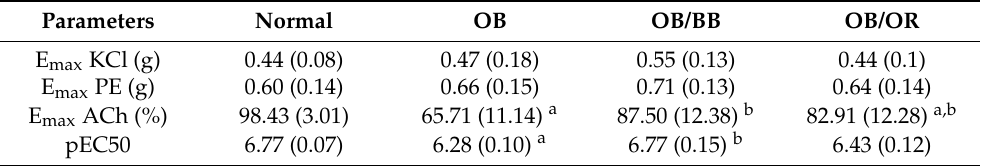
Table 2. Ex vivo aortic isolated tissue bath